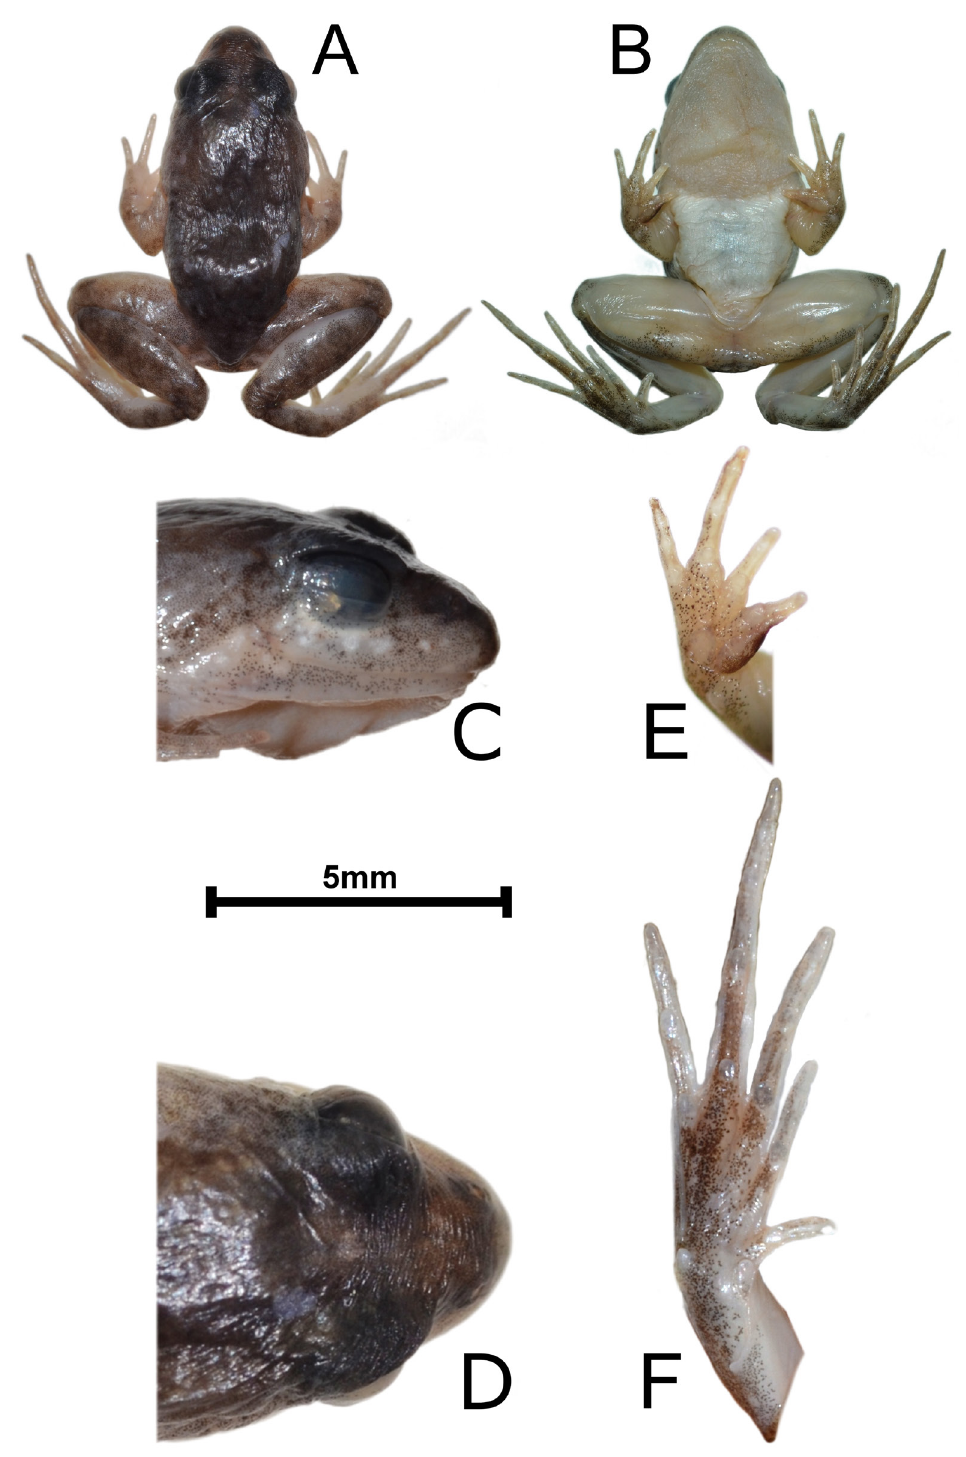
Fig. 2. Pseudopaludicola matuta sp. nov. holotype, adult ♂ (ZUEC 24302, SVL = 13.0 mm). A . Dorsal view. B . Ventral view. C . Head, lateral view. D . Head, dorsal view. E . Hand, ventral view. F . Foot, ventral view. Scale bar = 5